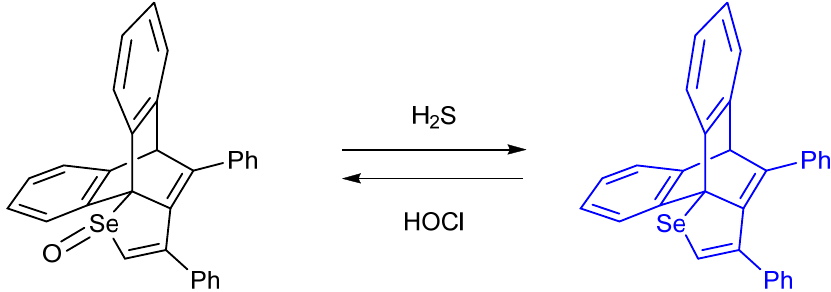
Figure 25. The intriguing dibenzobarrelene structures DbbSeO and MbbSeO used to detect H 2 S reversibly/resetably that involves a ka/selenide redox system by Annaka et al.